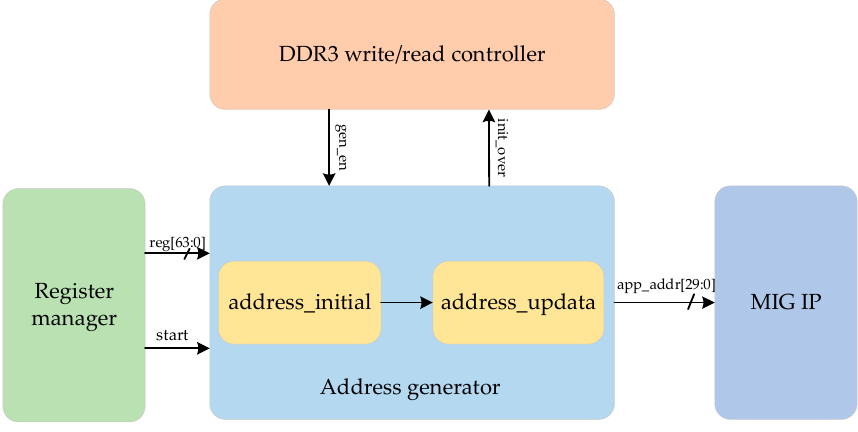
Figure 16. The architecture of the address generator.